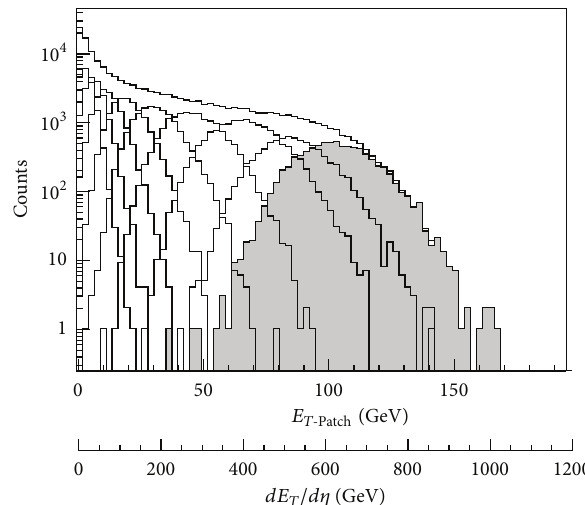
Figure 35: The midrapidity ( 0 < 𝜂 < 1 ) minimum bias distribution of total transverse energy along with distributions for different = 200 GeV, as is measured by the STAR centrality bins for √𝑠 NN experiment at RHIC. The shaded area corresponds to the 5 % most central bin. The main axis scale corresponds to the 𝐸 𝑇 measured in the detector acceptance and the bottom axis is corrected to represent the extrapolation to full azimuthal acceptance. The figure demonstrates the use of 𝐸 𝑇 distribution for estimation of collision centrality. The figure is taken from